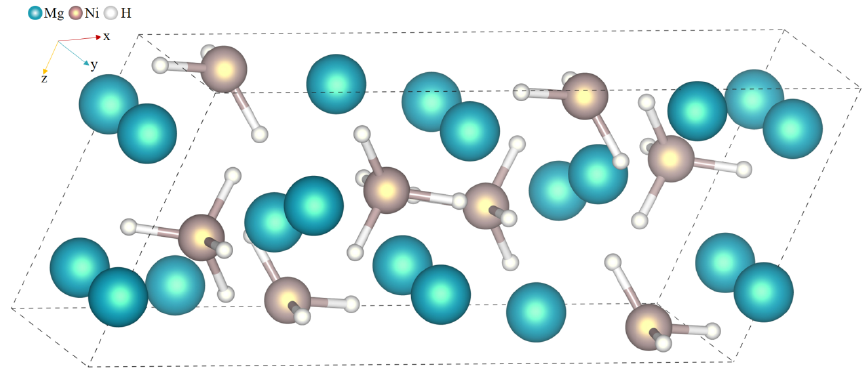
Figure 1. The unit cell of Mg 2 NiH 4 .Mg atoms are shown in cyan, Ni atoms are in brown and H atoms are in white